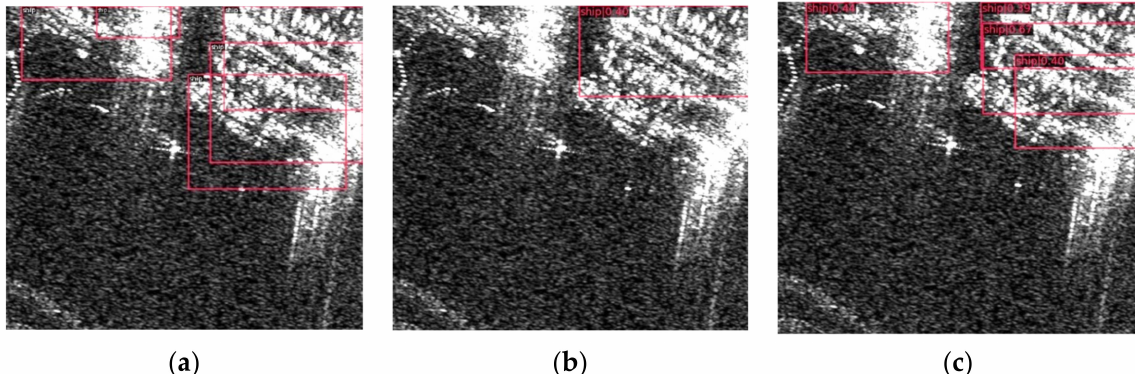
Figure 8. The slice of image with blurred ship contour and detection results obtained by baseline method and improved method: ( a ) ground Truth; ( b ) the Swin Transformer with FCOS; ( b , c ) added contour-guided shape-enhancement